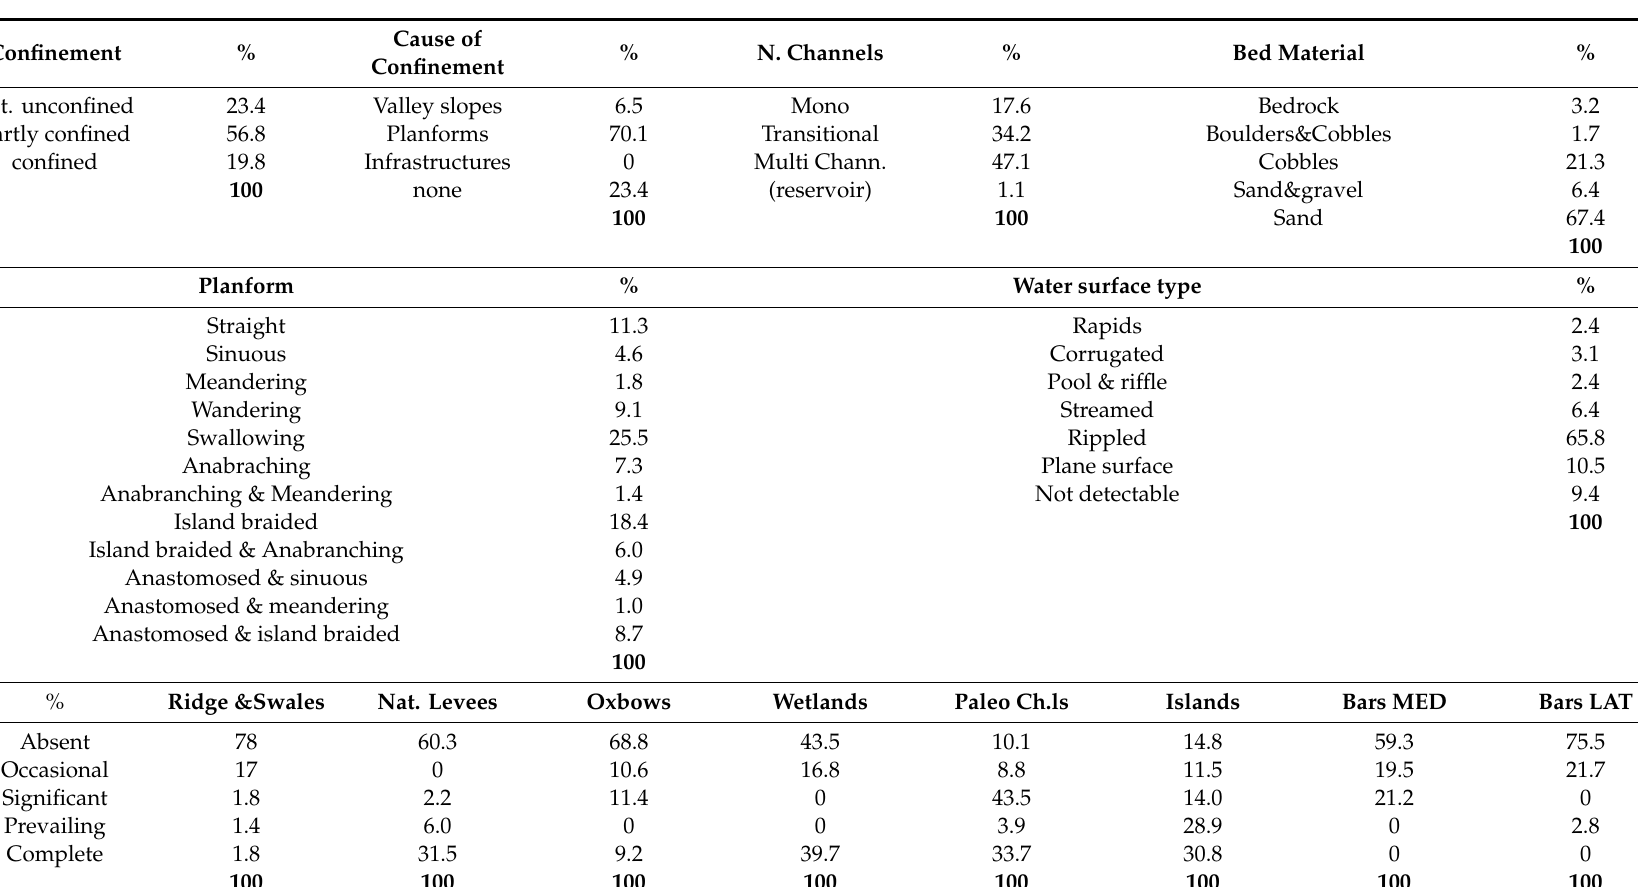
Table 2. Occurrence (% of river length excluding Betania reservoir) of values of RS attributes adopted for the Magdalena River. The attribute “islands” is the output of the reductionist-holistic algorithm applied with a significant length of 5 km (the 100 indicates the summation of the single % values). Confinement